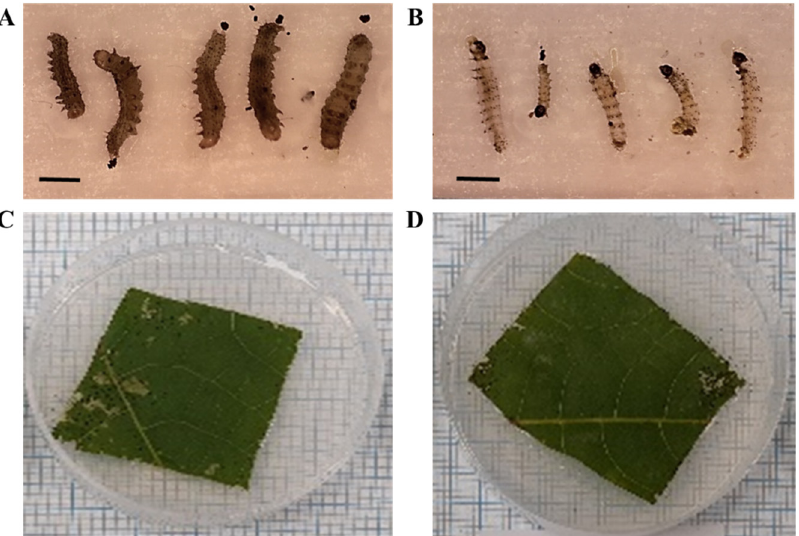
Figure 2. To assess larval development and larval feeding area, larvae and sacrificed plates were photographed, respectively. All pictured were taken with a background of millimeter paper (each small square is 1 mm by length and width) to set a scale for later image analysis. ( A ) Larvae ex- posed to aqueous solution formulated conidia after three days at low RH. ( B ) Larvae exposed to emulsion formulated conidia after three days at low RH. ( C ) Leaves treated with aqueous conidia after three days of larval feeding at low RH. ( D ) Leaves treated with Emulsion formulated conidia after three days of larval feeding at low RH. Table 1. Total sample sizes of larvae used to assess disease progression and larval development (length) 1 . Days